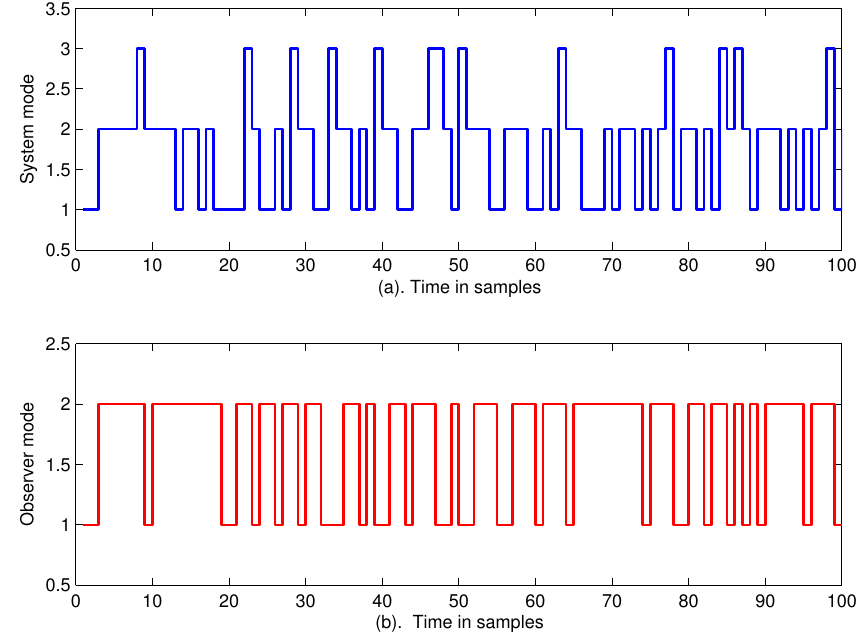
Figure 7. Simulation of system and observer